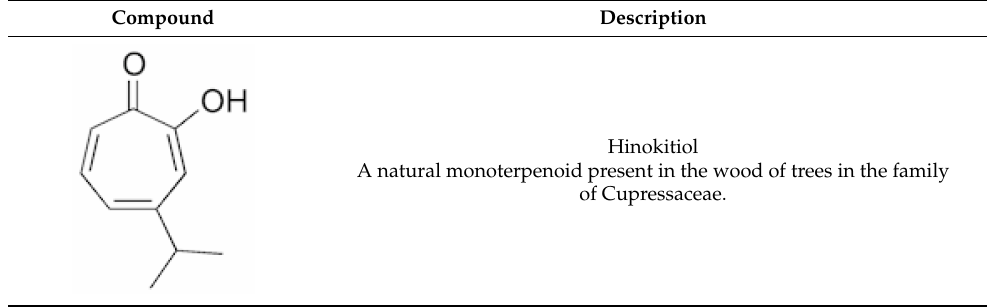
Table 4. Hinokitiol, a compound used as antimicrobial additive in medicinal